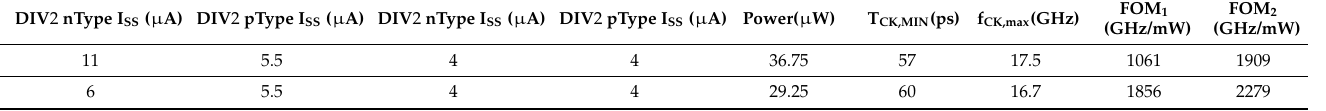
Table 4. Summary of dividers by 16 with nType and pType DIV2 without level shifters (with FBB).